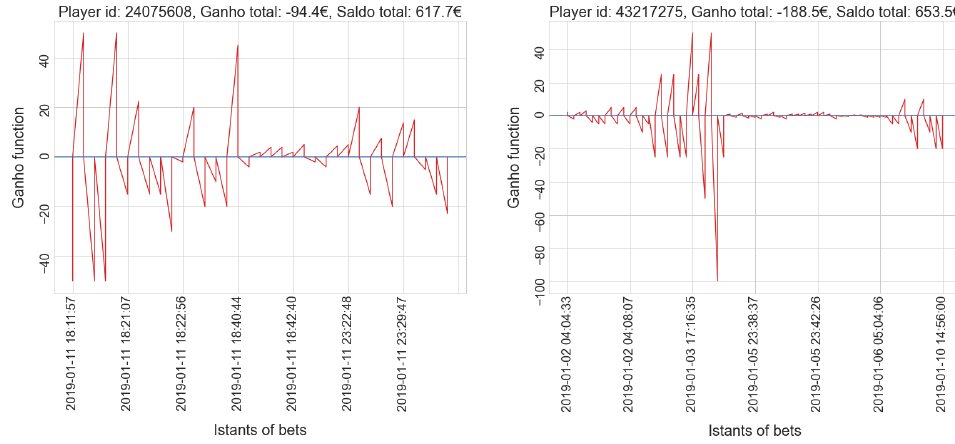
Figure 20. Time series plot of two players in Cluster 1.